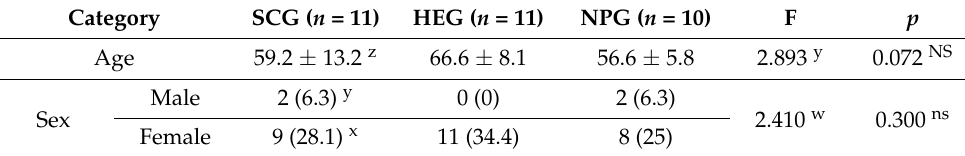
Table 2. Participants’ age, sex, and the test of homogeneity. Category